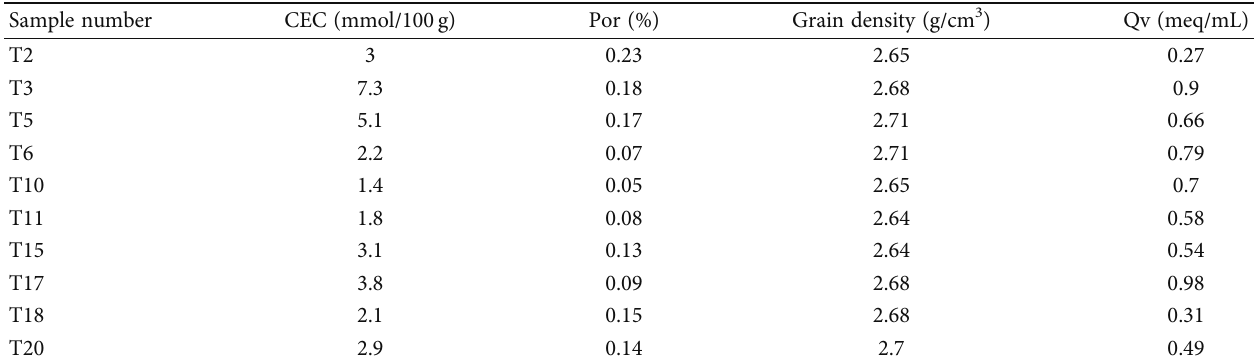
Figure 11: The structure of the random forest [32]. Table 3: Result of CEC and